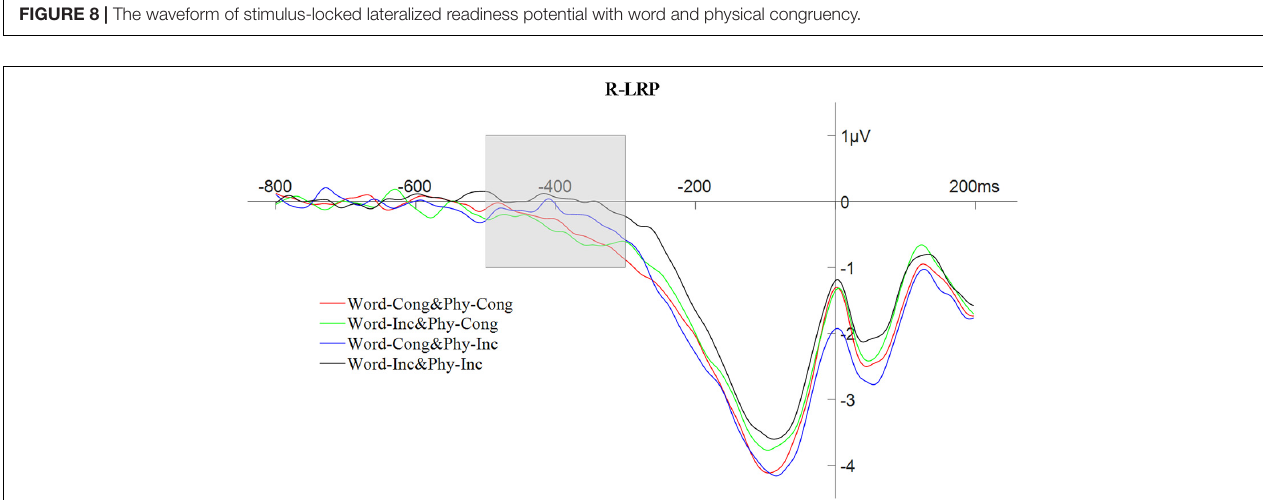
FIGURE 9 | The waveform of response-locked lateralized readiness potential with word and physical congruency.